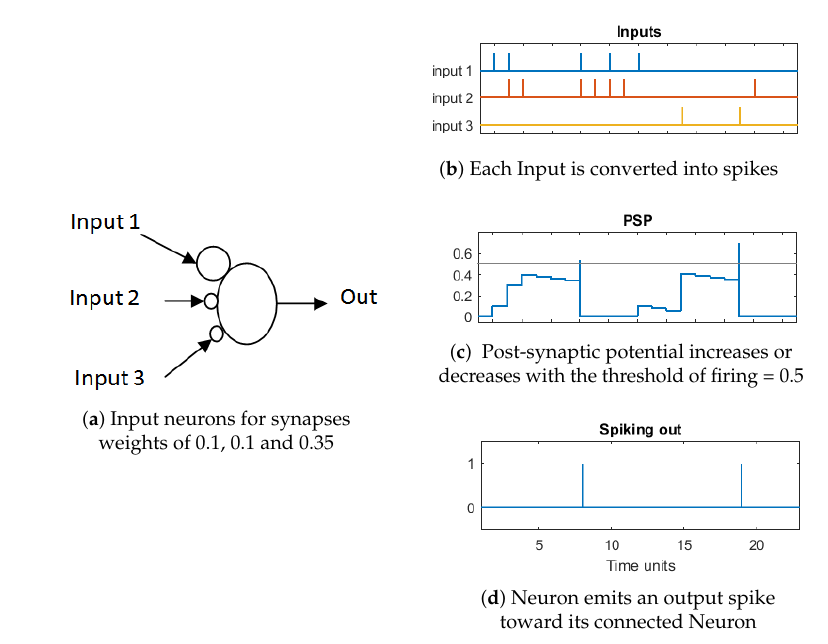
Figure 9. Leaky integrate-and-fire model (LIFM) neuron model. Small circles at neuron inputs represent connection weights. Note that input 1 has a bigger weight and it produces a larger effect in